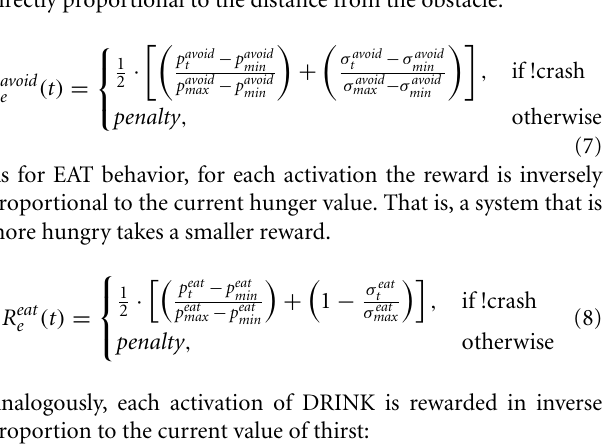
FIGURE 5 | E ( t ) is the current Energy level; E _ min : is the minimum amount of Energy permitting the system to work; E _ well : is the level of Energy corresponding to a wellness state of the